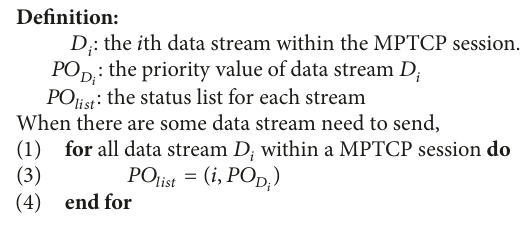
Table 1: Path configuration used in the